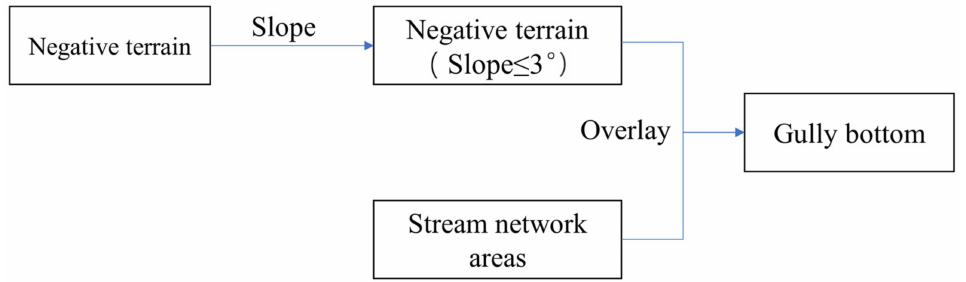
Figure 8. The process for gully bottom extraction.